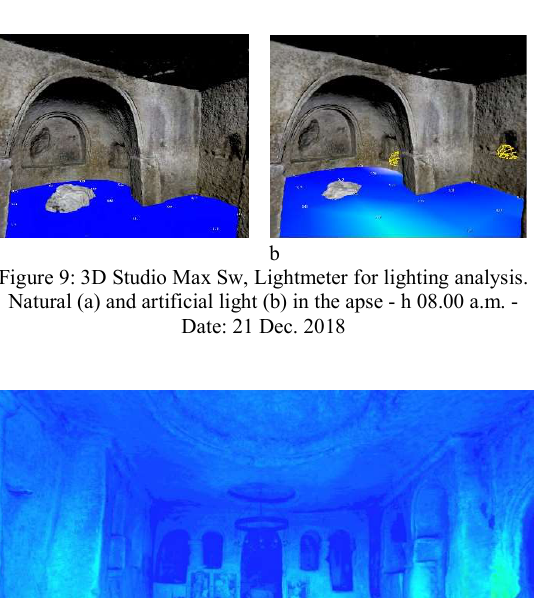
On the horizontal plane (h= 1m) the area near the entrance at 12:00 (with the maximum sky brightness) reaches along the axis